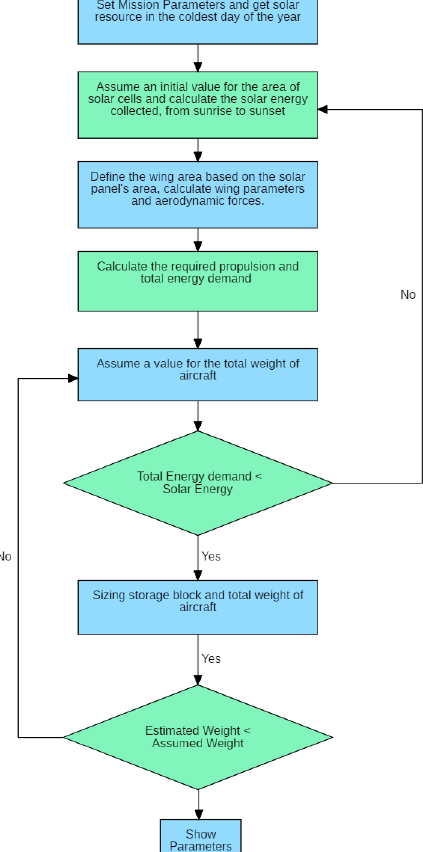
Figure 4. Flowchart of the UAV sizing process.